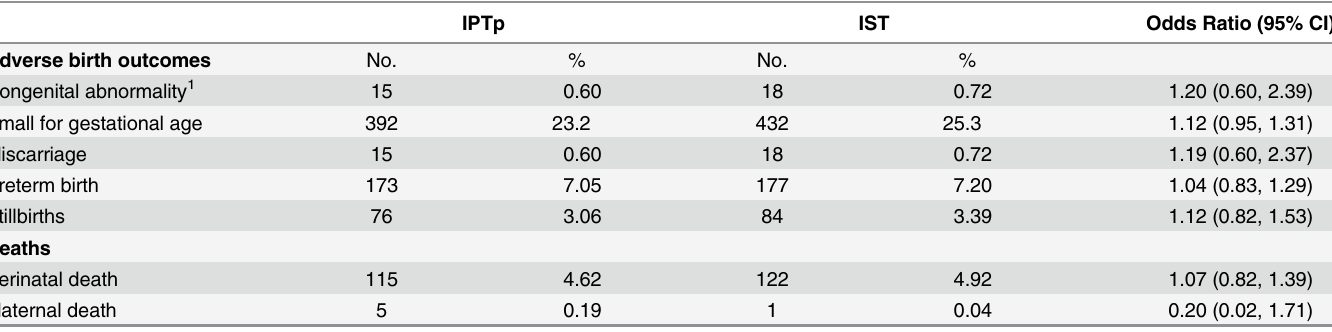
Table 4. Adverse birth outcomes and